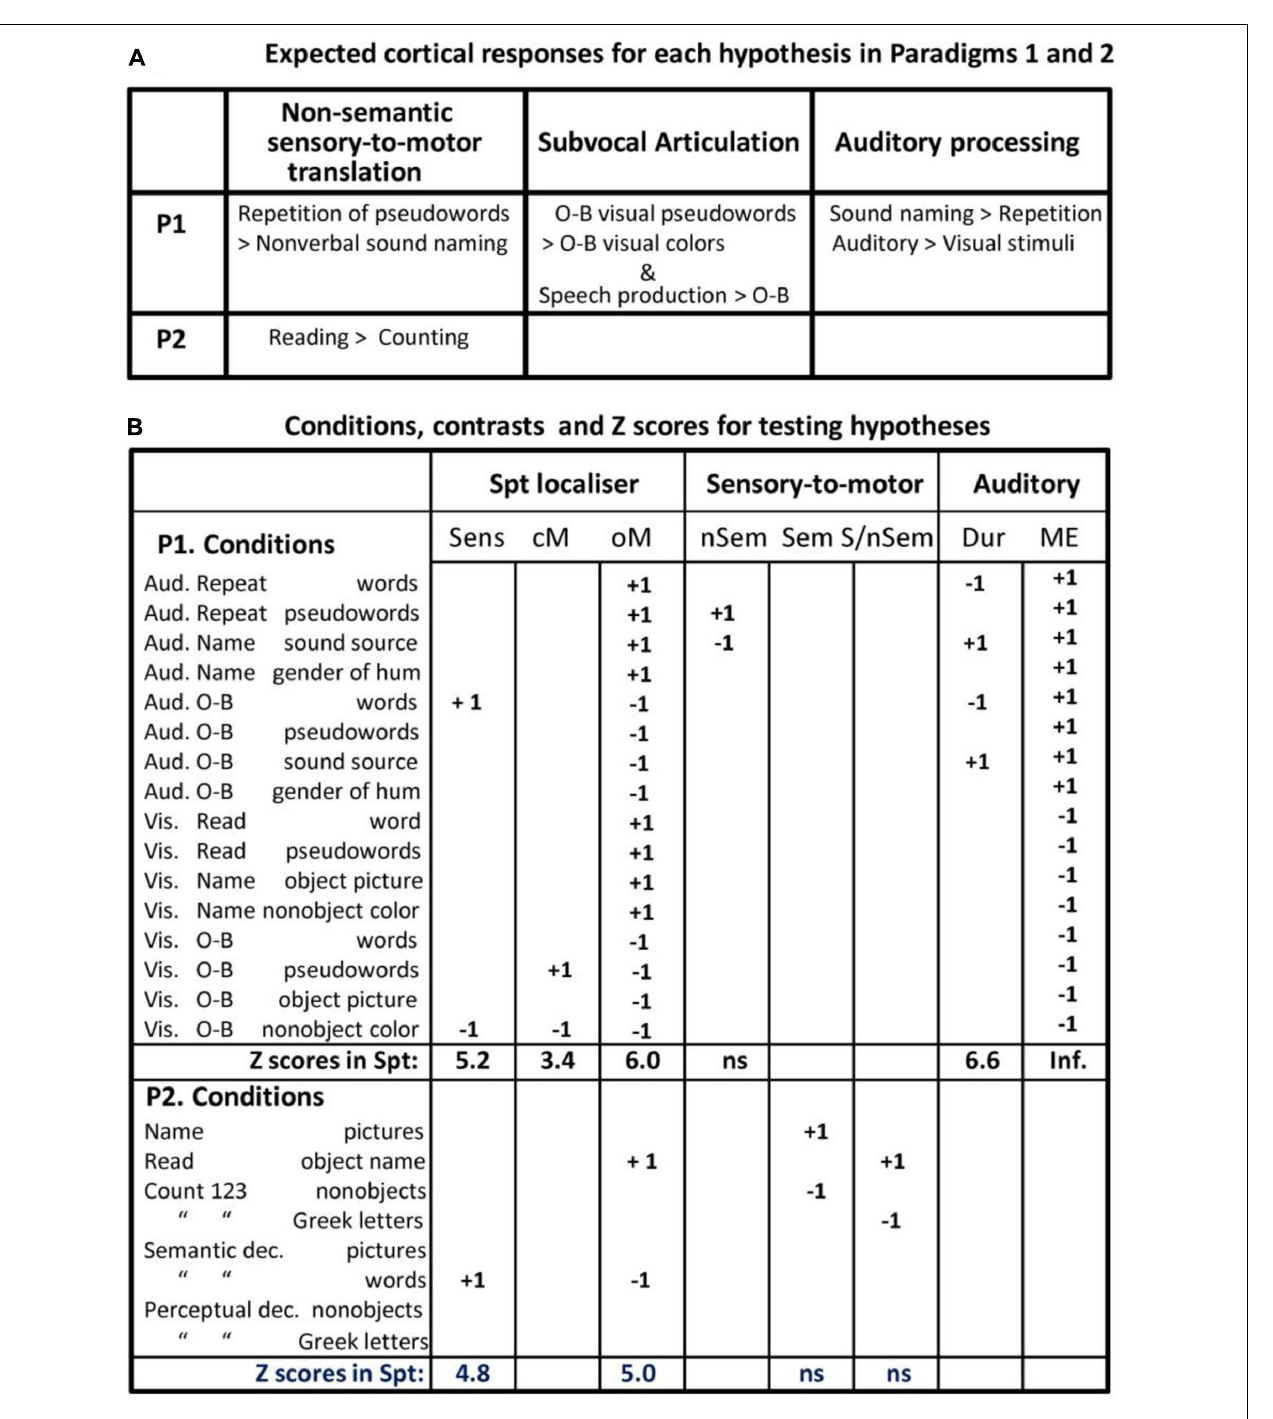
FIGURE 1 | Experimental hypothesis testing and results. (A ; top) describes the results that would support an interpretation of Spt activation in terms of sensory-to-motor integration, auditory imagery, and subvocal articulation. Note that the different accounts have opposing predictions for the same conditions (e.g., greater activation for pseudoword repetition than sound naming versus less activation for pseudoword repetition than sound naming). P1 = Paradigm 1, P2 = Paradigm 2 (see Materials and Methods). (B ; bottom) lists the 16 different conditions, the statistical contrast used to test the different